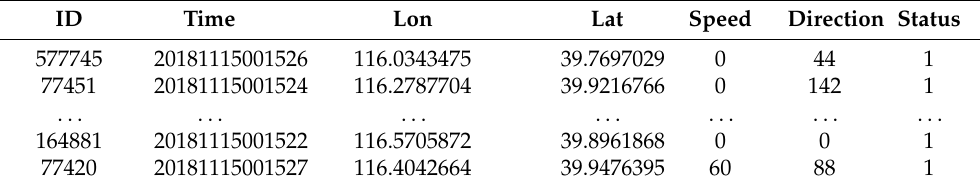
Table 1. Vehicle trajectory data.